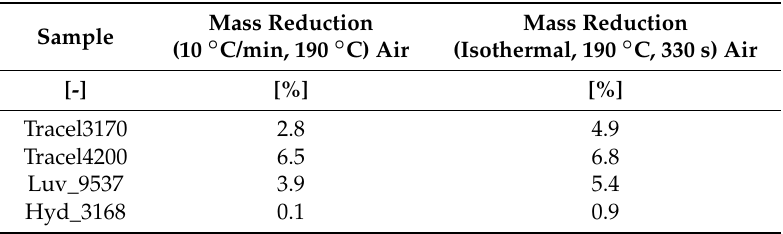
Figure 6. TGA decomposition of foaming agents at 190 °C in isothermal conditions in a measuring atmosphere of air ( a ) mass reduction as a function of time, ( b ) dTG as a function of time (the blue line shows the moment of reaching 190 °C). Table 5. The decomposition range of CBAs at an isothermal temperature.